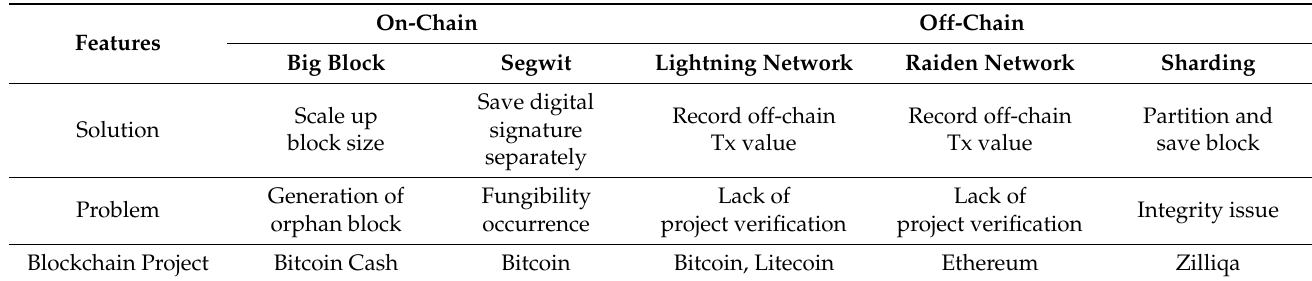
Table 1. Comparison between Existing Scalability Solutions.